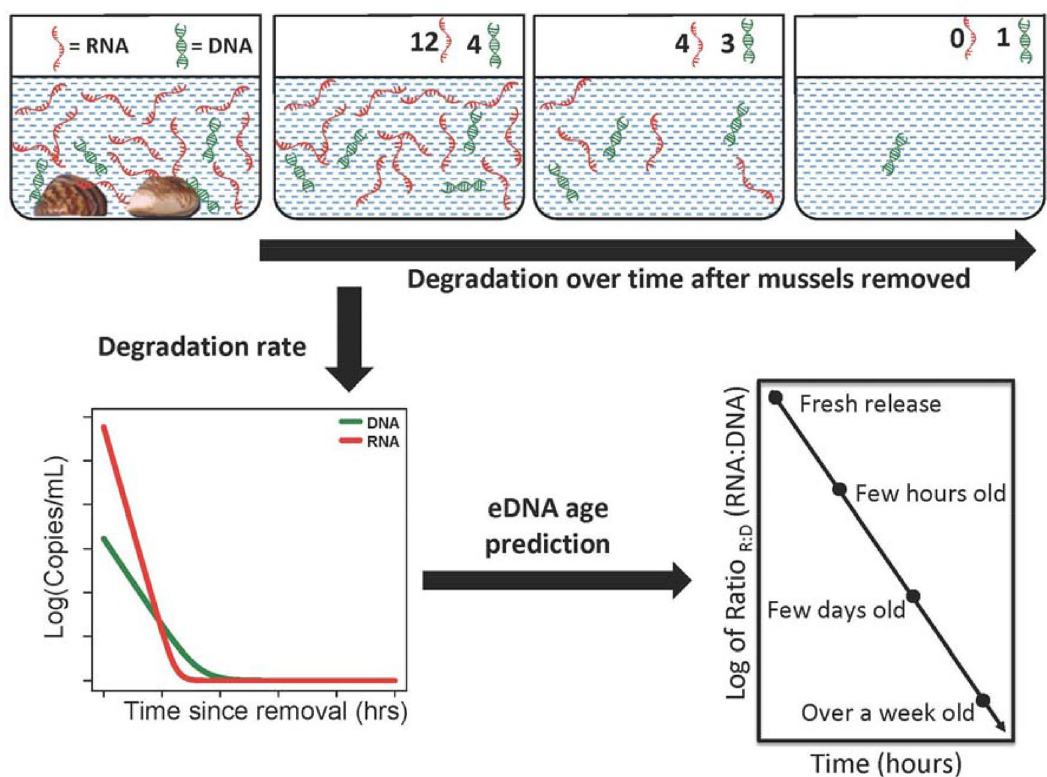
Figure 1. Schematic of experimental design, in which the degradation rates of environmental (e)DNA and (e)RNA were compared across multiple genes collected in environmental genomic material released from dreissenid mussels. The concentration of eRNA depletes faster than eDNA, providing a predictor for estimating time since genomic material